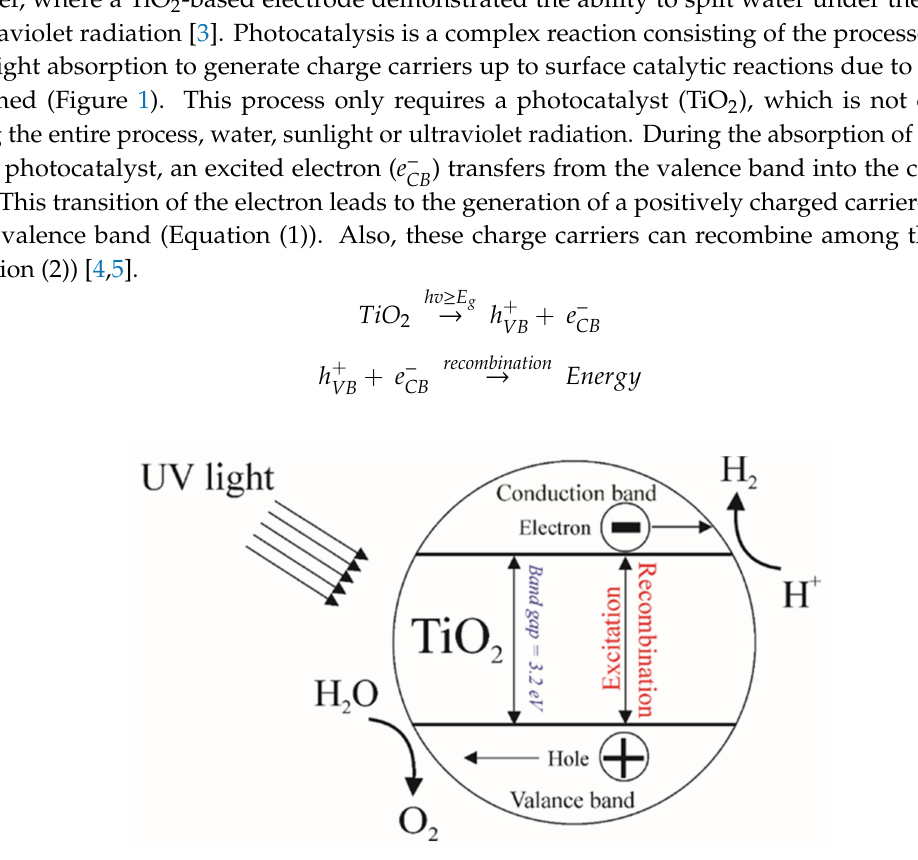
Figure 1. The mechanism of photocatalytic water splitting on TiO 2 based